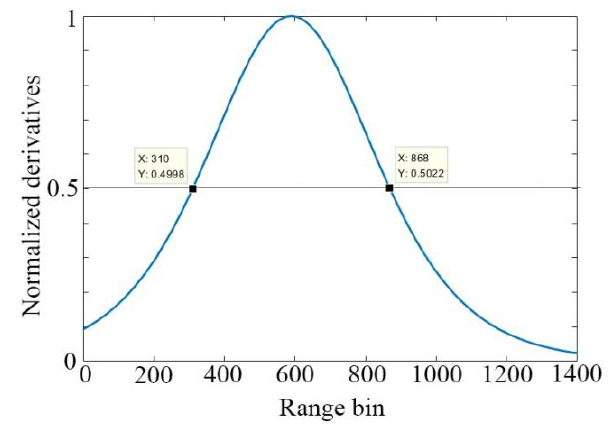
Figure 5. The derivative of the modified Sigmoid function.